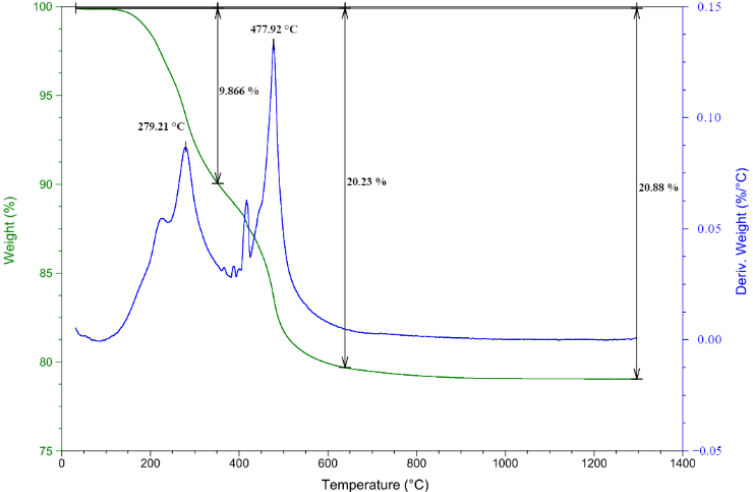
Figure 5. The results of the TGA, DTG. The mineralisation and removal of the methyl groups from the siloxane should occur at 478 °C.